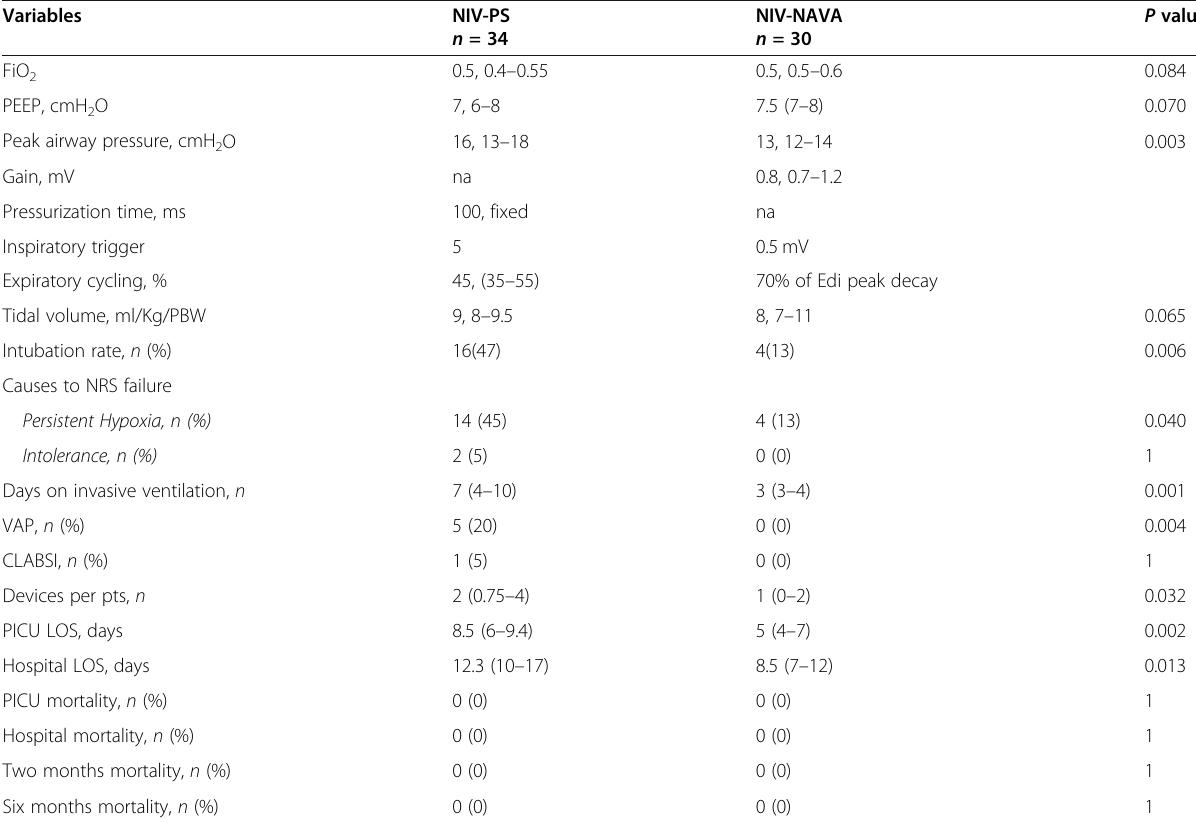
Table 2 Outcome variables